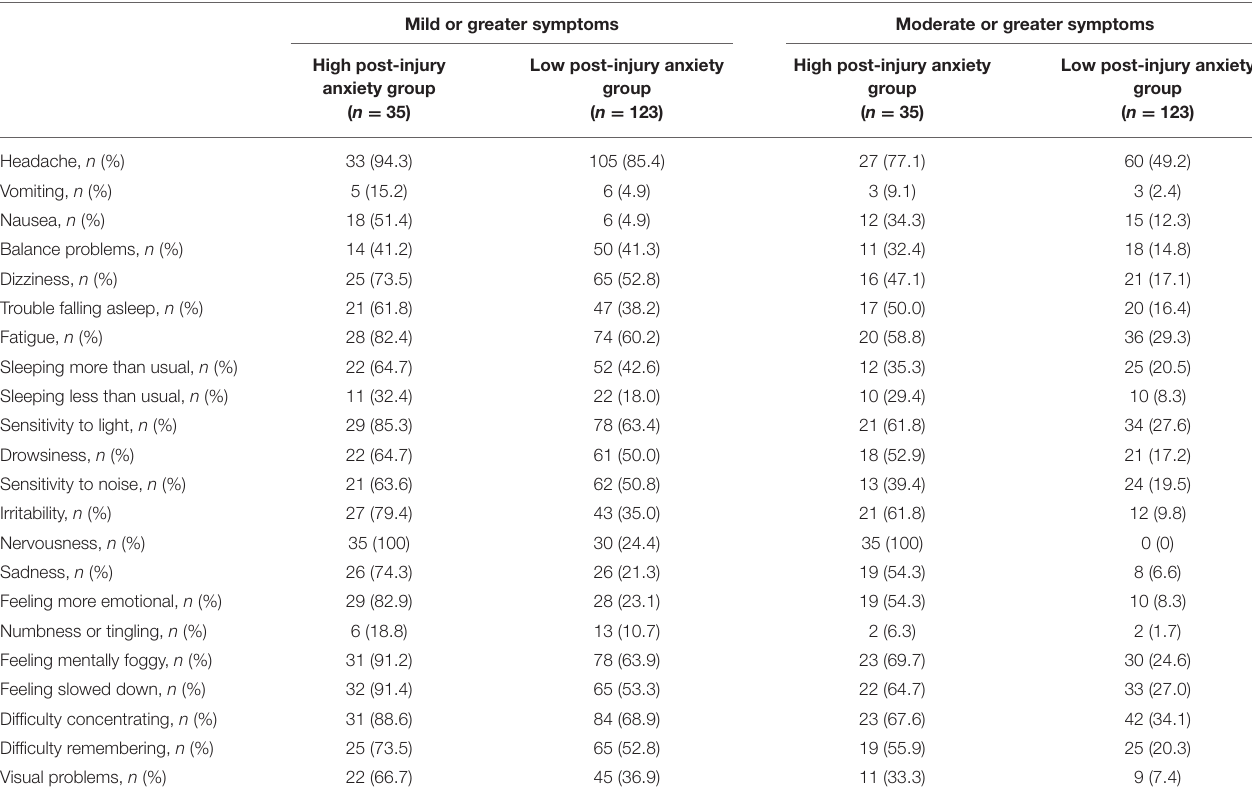
TABLE 3 | Endorsement of individual symptoms stratified by current anxiety.